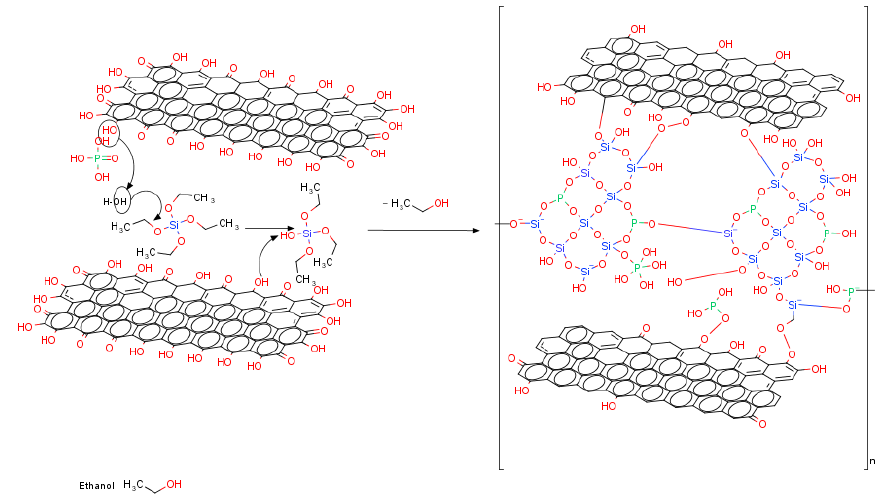
Figure 2. Schematic representation of the process reactions.